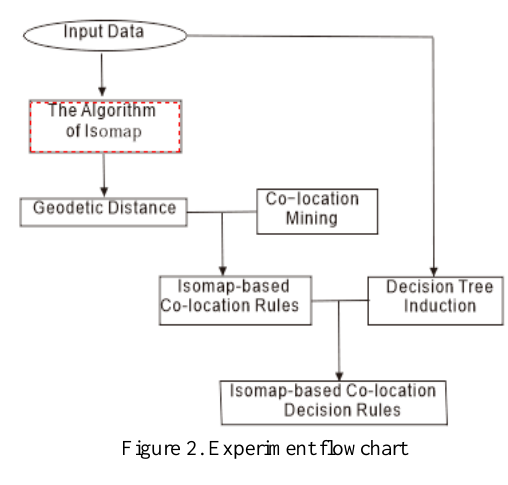
Figure 2. Experiment